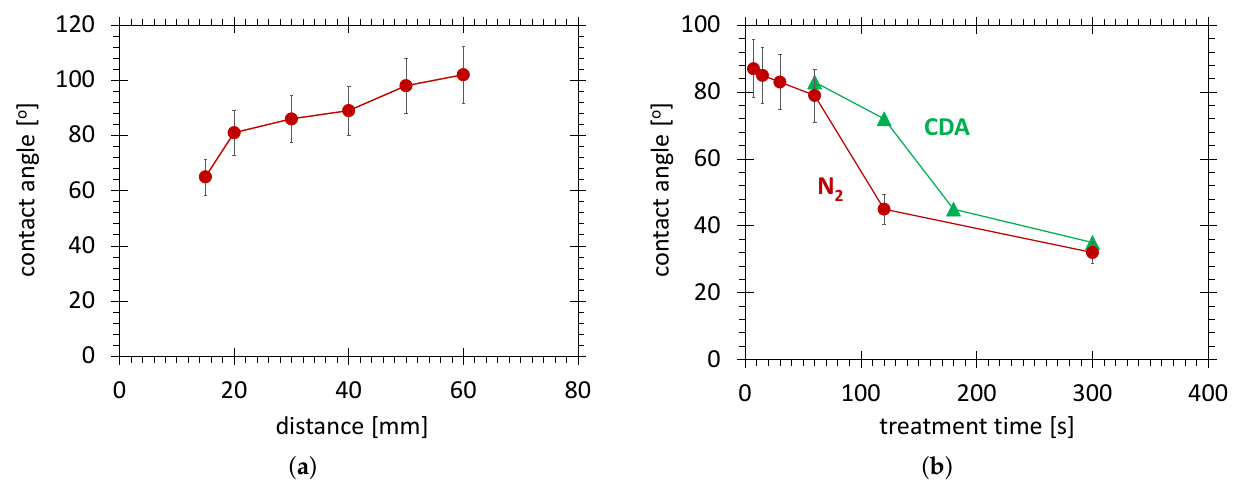
Figure 10. The contact angle of the DI water on the fruit surface treated by PDD ( a ) on the apple surface treated 2 min, and ( b ) on the lime surface at a distance 15 mm and 35 mm for CDA and nitrogen, respectively. The gas flow is 7 SLM for all